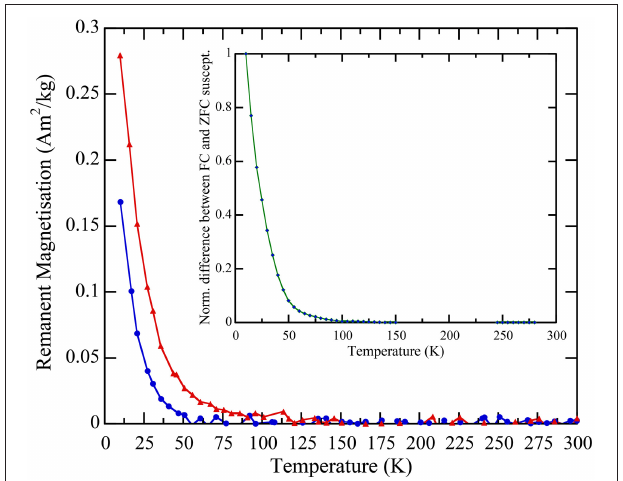
FIGURE 11 | ZFC (in blue) and FC (in red) isothermal remanent magnetization (IRM) curves obtained using a 2.5 T magnetic induction applied at 10 K after cooling in zero field (ZFC) or in 2.5 T (FC). Inset: temperature evolution of the difference between the FC and ZFC dc susceptibility curves of Figure 8